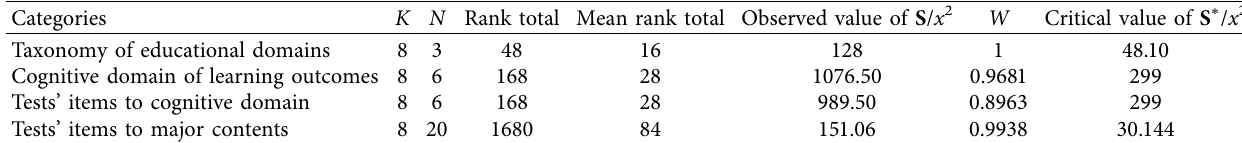
Table 2: The coefficient of concordance ( W ) observed value of S / x 2 and the critical value of S ∗ / x 2 associated with W ’s